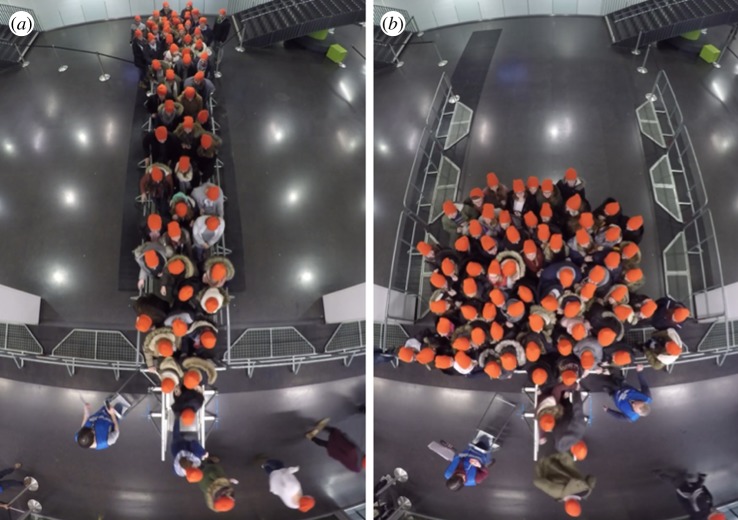
Screenshots of the video sequences at time t = 5 s for Run 110 with w = 1.2 m (a) and Run 030 with w = 5.6 m (b).